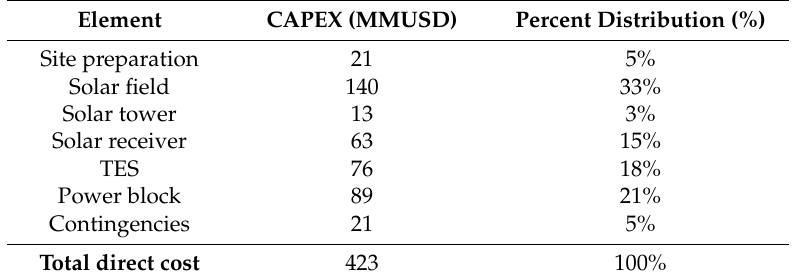
Table 2. CAPEX required for a CSP tower plant of 130 MWe with 13 h of TES [33,34].